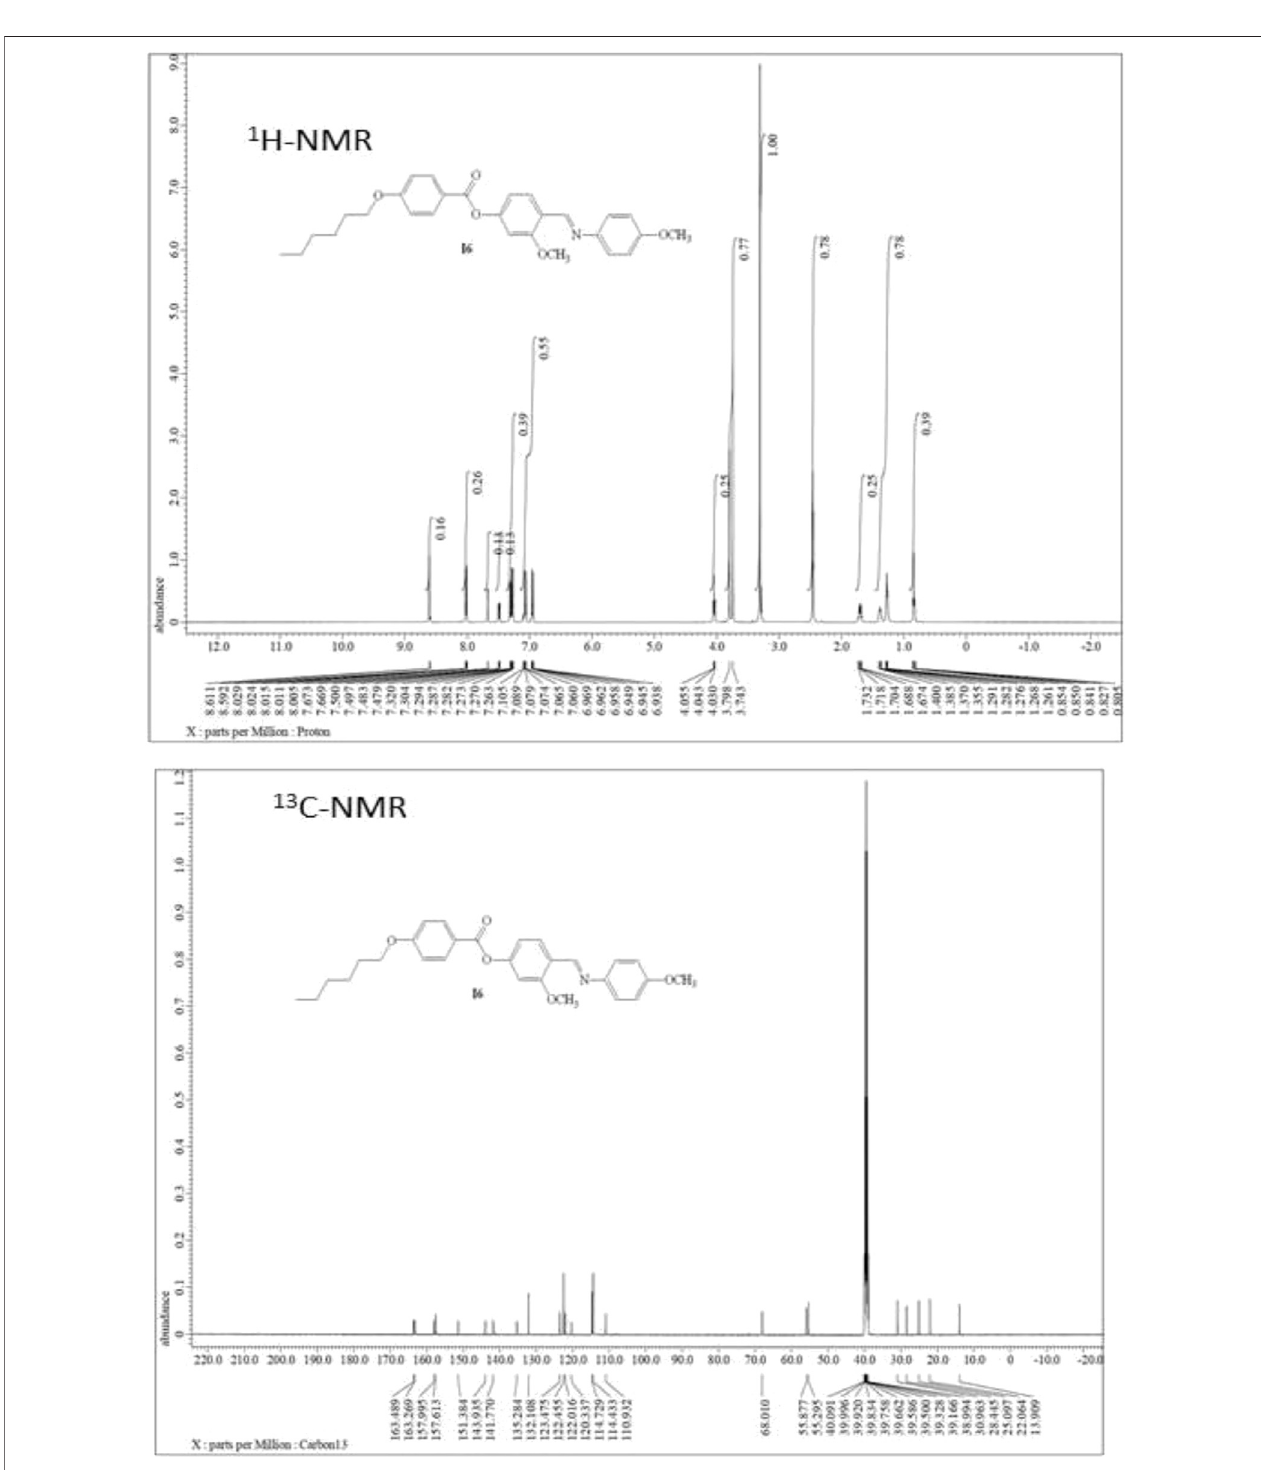
FIGURE 1 | NMR spectra of material A6